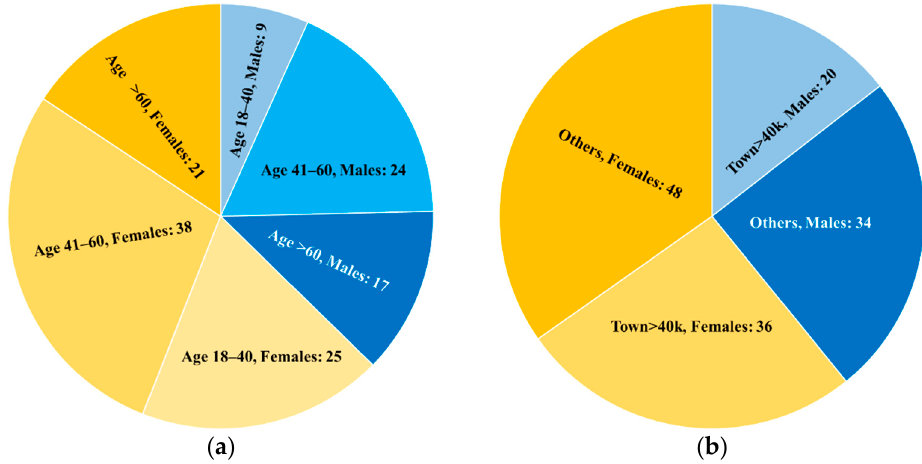
Figure 3. Basic demographic features of participants to forest therapy sessions: ( a ) Distribution by age group and gender; ( b ) Distribution by residence and gender. Table 2. Data about age, height and weight of participants to each forest therapy